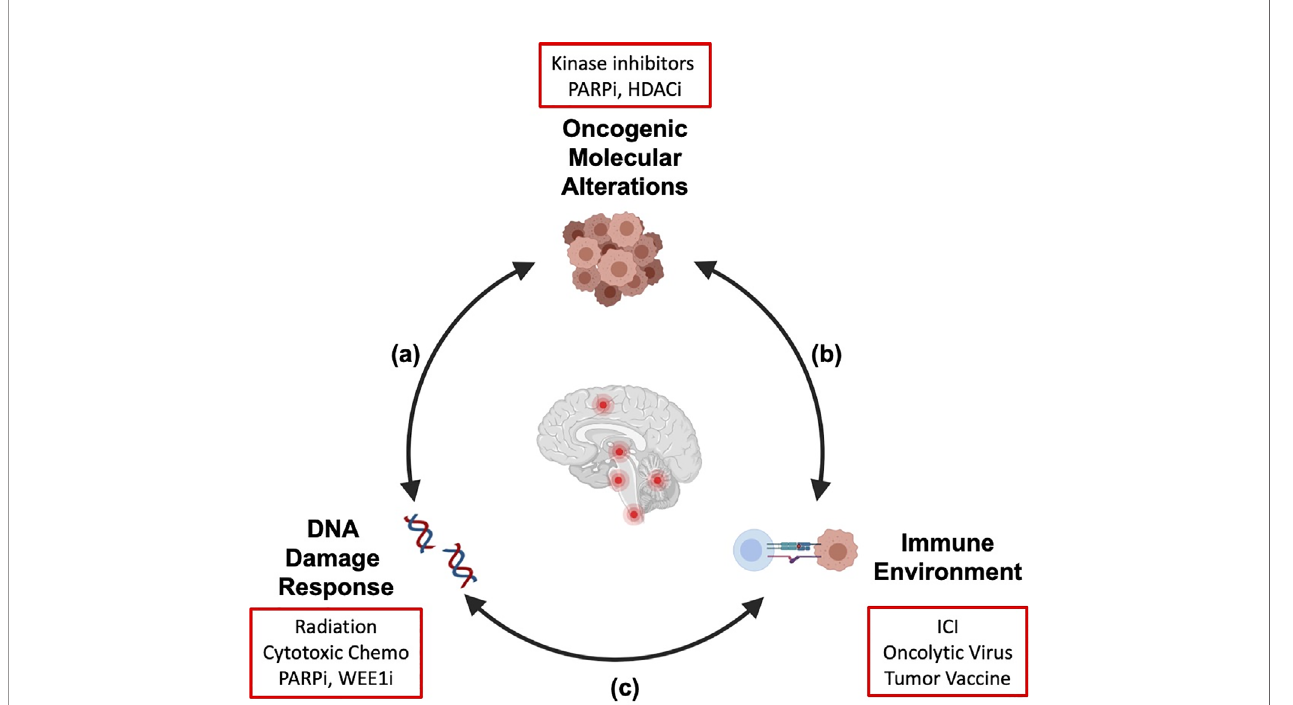
FIGURE 1 | Crosstalk between key hallmarks of cancer informs combination strategies for treatment of pediatric brain tumors. The molecular alterations that drive pediatric brain tumors modulate the cellular response to DNA damage (A) and shape the tumor immune microenvironment (B) . Radiation therapy induces DNA damage and remodels the tumor immune microenvironment (C) . As targeted therapies and immunotherapies are integrated into treatment regimens for patients with pediatric brain tumors, a systematic understanding of these interactions will be necessary to generate combination strategies that are ef fi cacious and safe. Examples of therapeutic agents discussed in this review are shown (red boxes). We propose that his integrated framework should be considered in preclinical and clinical studies to identify molecular determinants of therapy response and inform rational design for combination strategies. Created with